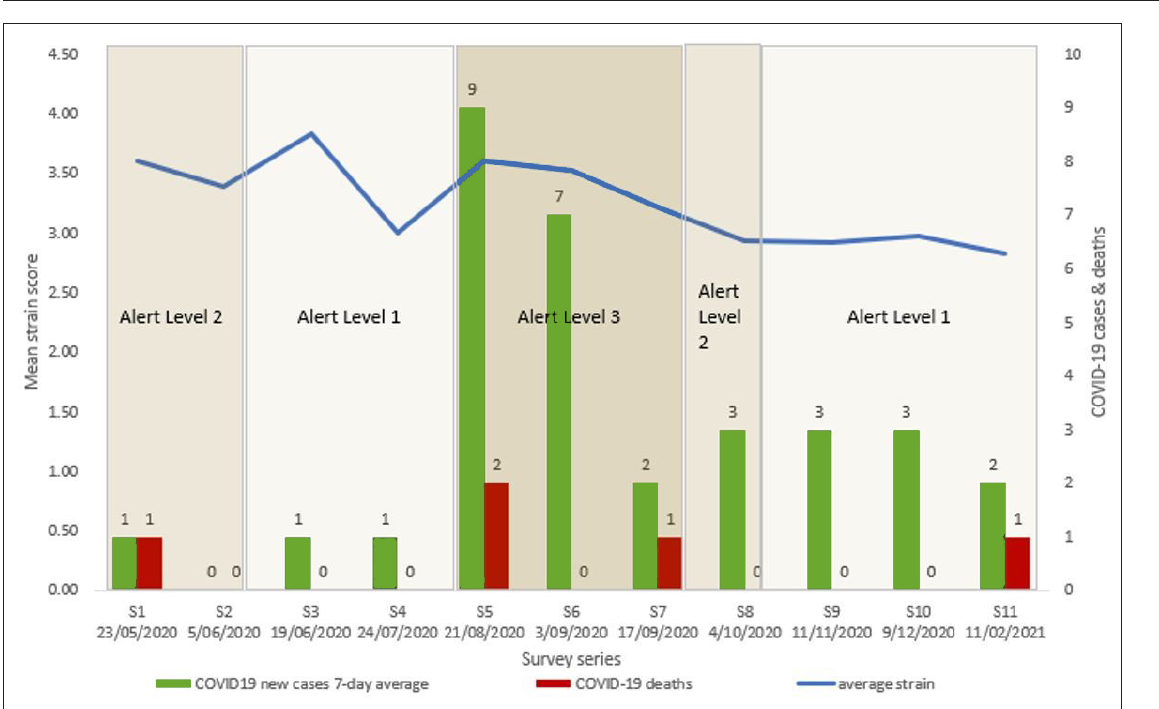
Figure 1 Mean strain scores, COVID- 19 cases and deaths, and alert levels during survey series. New cases include both border arrivals in managed isolation and community spread. Alert levels are for Auckland: occasionally there was a lower level for the rest of the